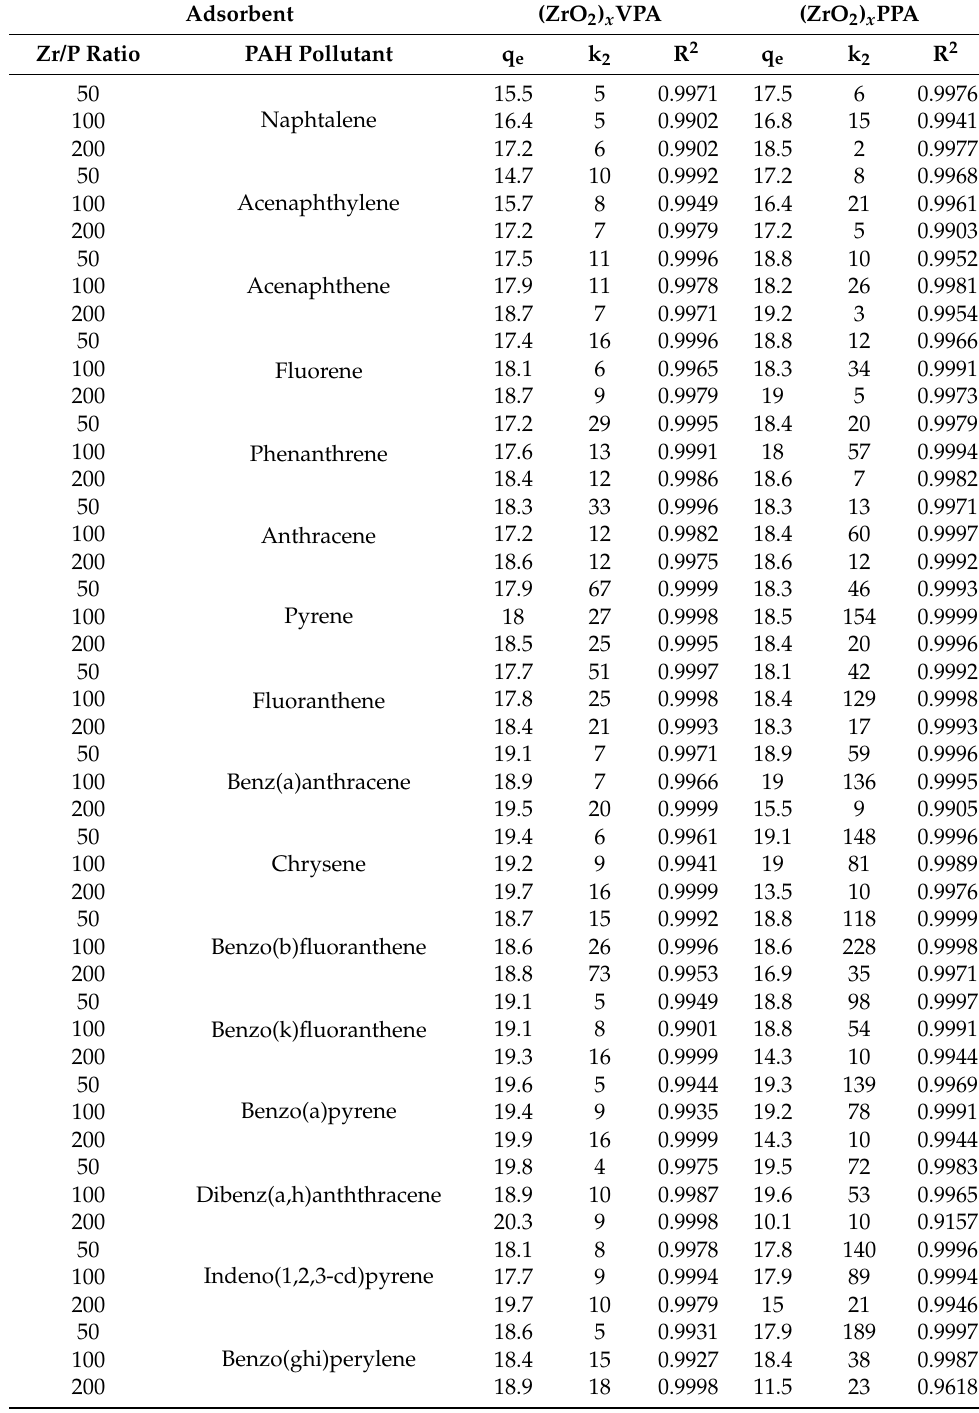
Table 2. Adsorption capacities (q e ) ( µ g · g − 1 ), pseudo-second order rate constant (k 2 ) (g · mg − 1 · min − 1 ), and fit accuracy using a pseudo-second-order kinetic plot for the adsorption of 16 polycyclic aromatic hydrocarbons (PAHs) onto (ZrO 2 ) x (VPA) and (ZrO 2 ) x (PPA) nanocomposites.